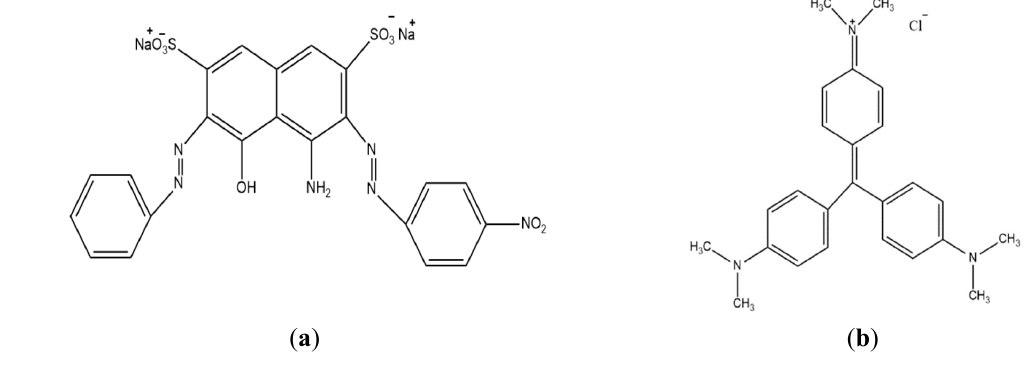
Figure 1. Structure of ( a ) naphthol blue black and ( b ) crystal violet.